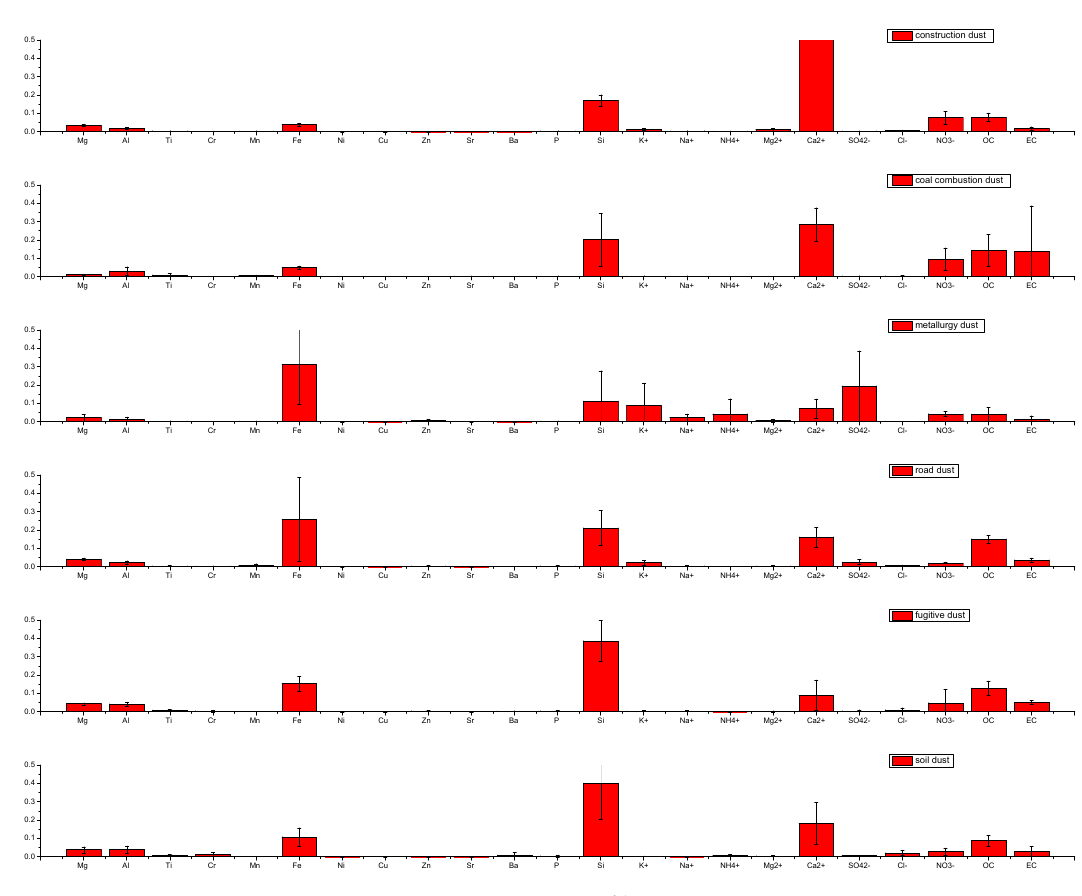
Figure 5. PM 2.5 source profiles in Xingtai.